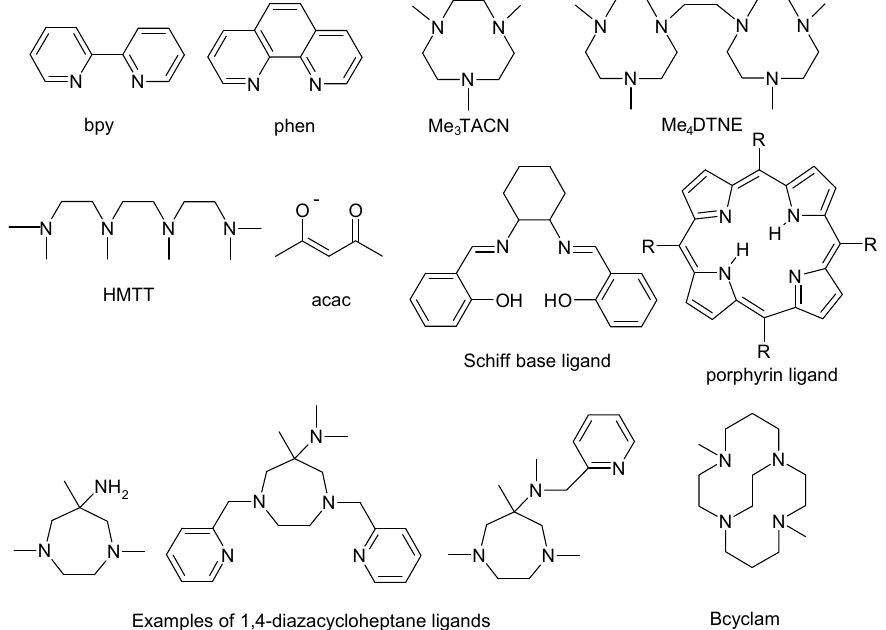
Figure 3. Ligands exhibiting paint drying activity with Mn salts or as Mn-ligand complexes discussed in the text: 2,2 ′ -bipyridine (bpy), 1,10-phenanthroline (phen), 1,4,7-trimethyl-1,4,7-triazacyclononane (Me 3 TACN), 1,2-bis(4,7-dimethyl-1,4,7-triazacyclononan-1-yl)-ethane (Me 4 DTNE), N , N , N ′ , N ″ , N ′′′ , N ′′′ -hexamethyltriethylenetetraamine (HMTT), acetylacetonate (acac), N , N ′ -bis(salicylidene)cyclohexylenediamine (Schiff-base ligand), 5,10,15,20-tetrakisphenylporphyrin and 5,10,15,20-tetrakis(4 ′ -methoxyphenyl)porphyrin (R = phenyl and 4-methoxyphenyl, respectively; porphyrin ligand), 6-amino-1,4,6-trimethyl-1,4-diazacycloheptane, 6-dimethylamino-1,4-bis(pyridine-2-ylmethyl)-6-methyl-1,4-diazacycloheptane, 1,4,6-trimethyl-6{ N -pyridin-2-ylmethyl)- N -methylamino}-1,4-diazacycloheptane (examples of 1,4-diazacycloheptane based ligands), 4,11-dimethyl-1,4,8,11-tetraazabicyclo[6.6.2]hexadecane (Bcyclam).